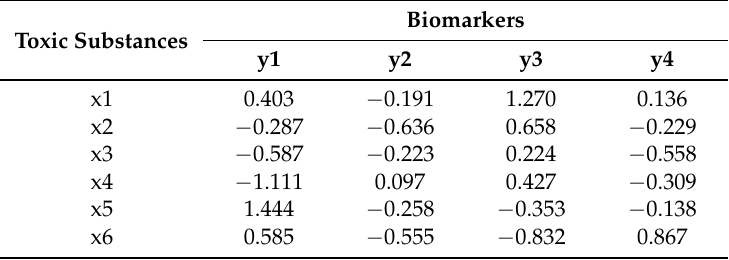
Table 4. The normalization coefficients of acute toxic biomarkers and toxic substances.